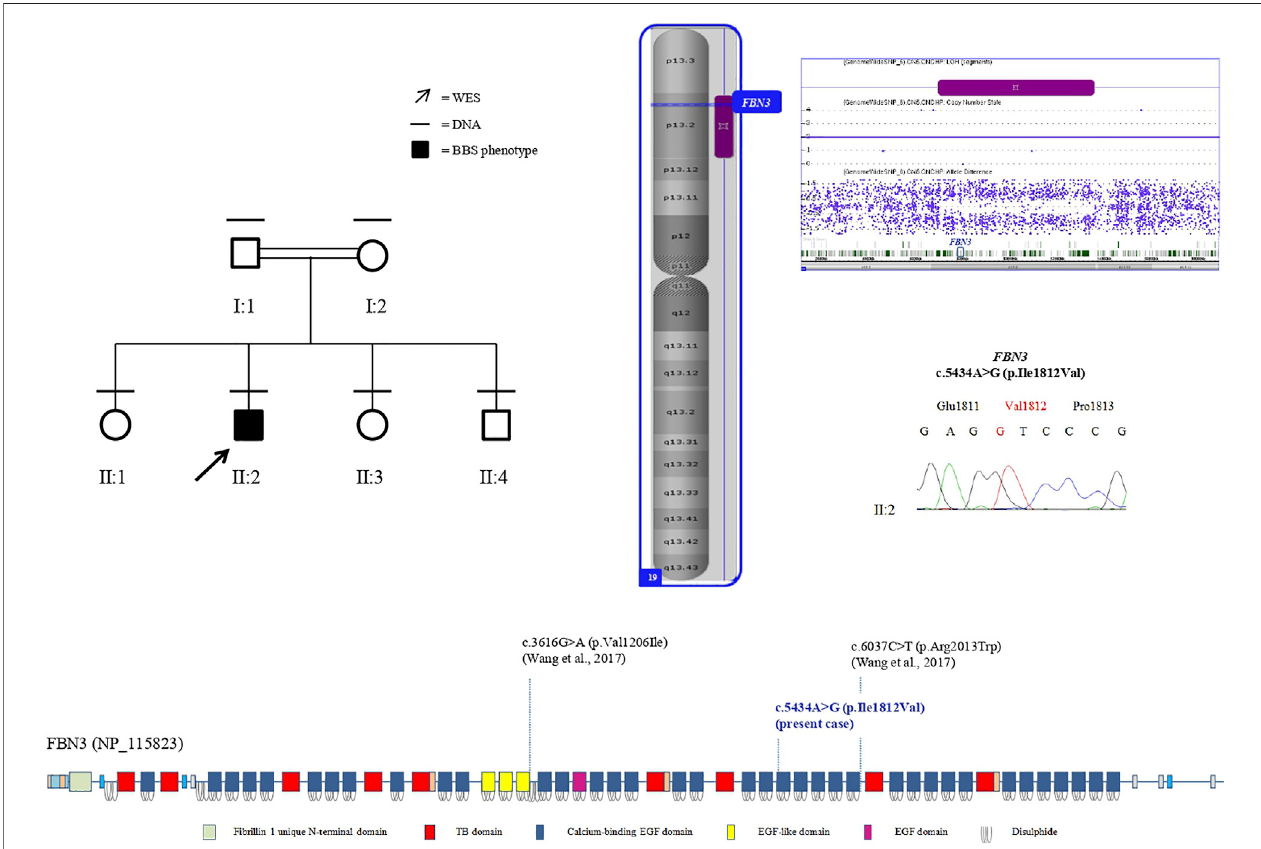
FIGURE 2 | Left: pedigree of the family. Black lines indicate individuals for whom DNA was collected; the arrow indicates the proband that underwent WES. Right: thesolepatient ’ sROH(purplebar)onchromosome19,including FBN3 ,assessedbySNP-arrayanalysis(imagedbyChASsoftware,v3.1).Electropherogramshowsthe proband ’ s homozygous genotype of FBN3 (c.5434A > G) variant. Below: protein domains scheme of FBN3 reconstructed from Pfam (https://pfam.xfam.org/protein/ Q75N90) and localization of variants reported so